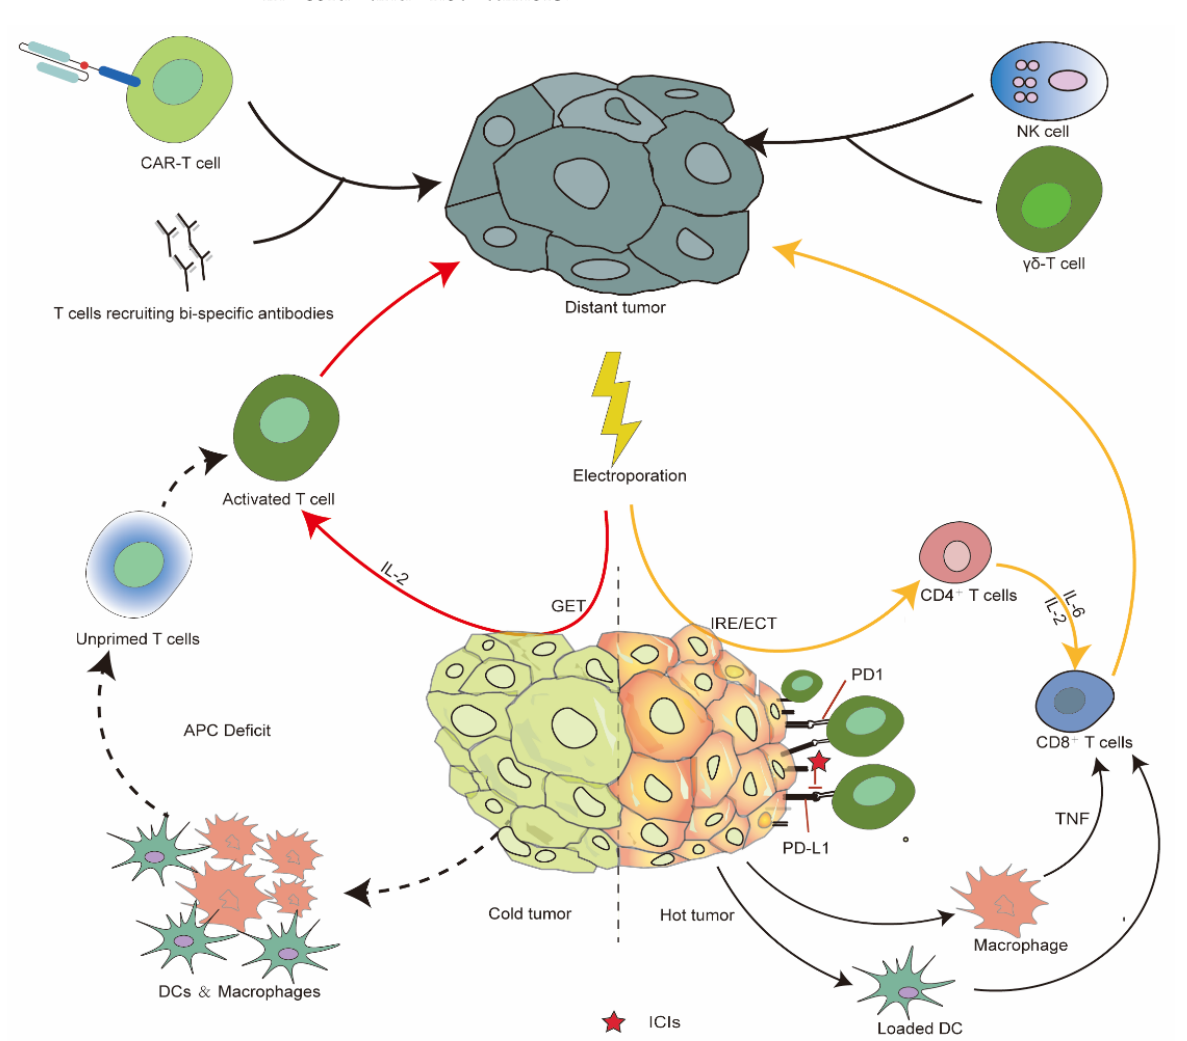
Figure 3. Electroporation-related therapies induce a systematic immune response combined with immunotherapy in “cold” and “hot” tumors. DC, dendritic cell; ECT, electrochemotherapy; GET, gene electrotransfer; IRE, irreversible electroporation; RE: reversible electroporation; NK cell, natural killer cell; PD-1, programmed death receptor 1; PD-L1, programmed death-ligand 1; TNF, tumor necrosis